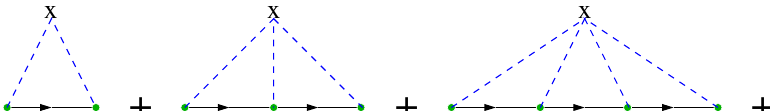
Figure 15. The first few graphs of the CPA local self-energy of the Anderson model. Here the solid Green’s function line represents the average local propagator and the dashed lines the impurity scattering. These graphs may be obtained from the full set of graphs shown in Figure 12 by replacing each graphical element (Green’s function and impurity scattering lines) with its local analog coarse-grained through the entire first Brillouin